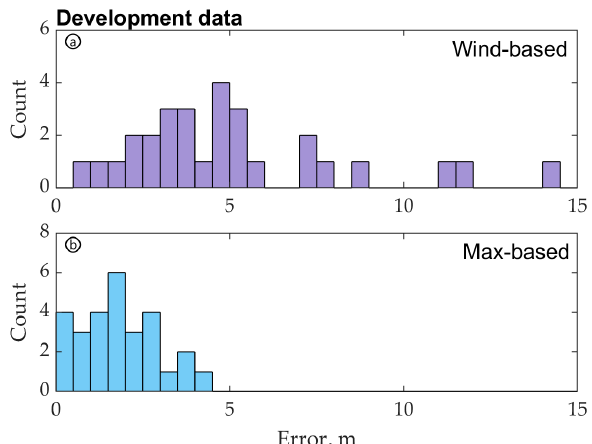
Figure 7. Performance in estimating leak position on the Texas controlled release dataset, using the ( a ) wind back-projection and ( b ) maximum methane-based methods described in Section 3.1. Absolute errors are shown for both methods.